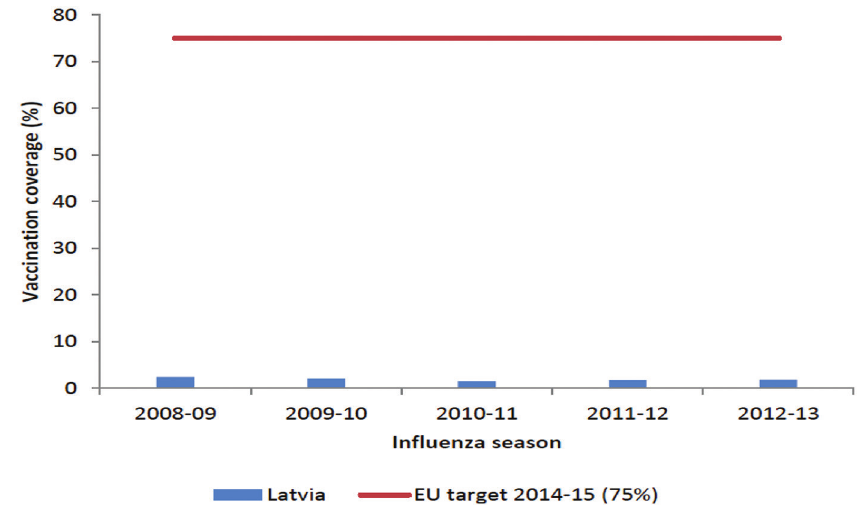
Figure 5. Seasonalinfluenzavaccinationcoverageamongthose≥65yearsofagefromthe2008–09tothe2012–13influenzaseasonfrom([67],p.4).